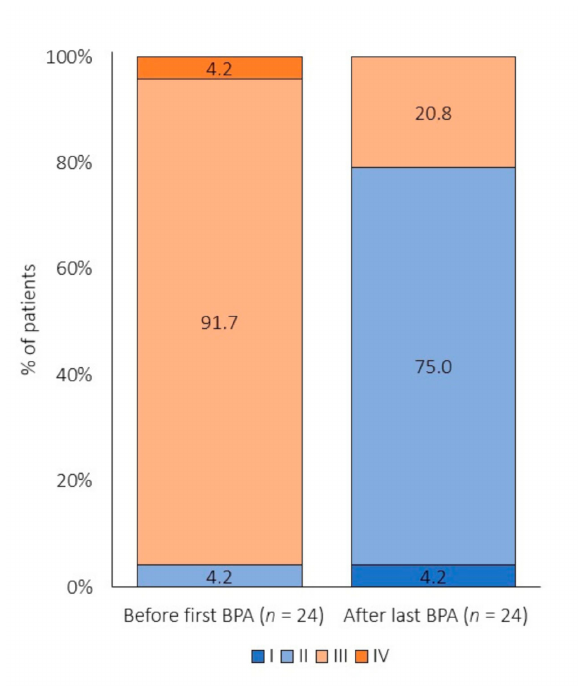
Figure 3. NYHA functional class before the first and after the last BPA session. Abbreviations: NYHA—New York Heart Association and BPA—balloon pulmonary